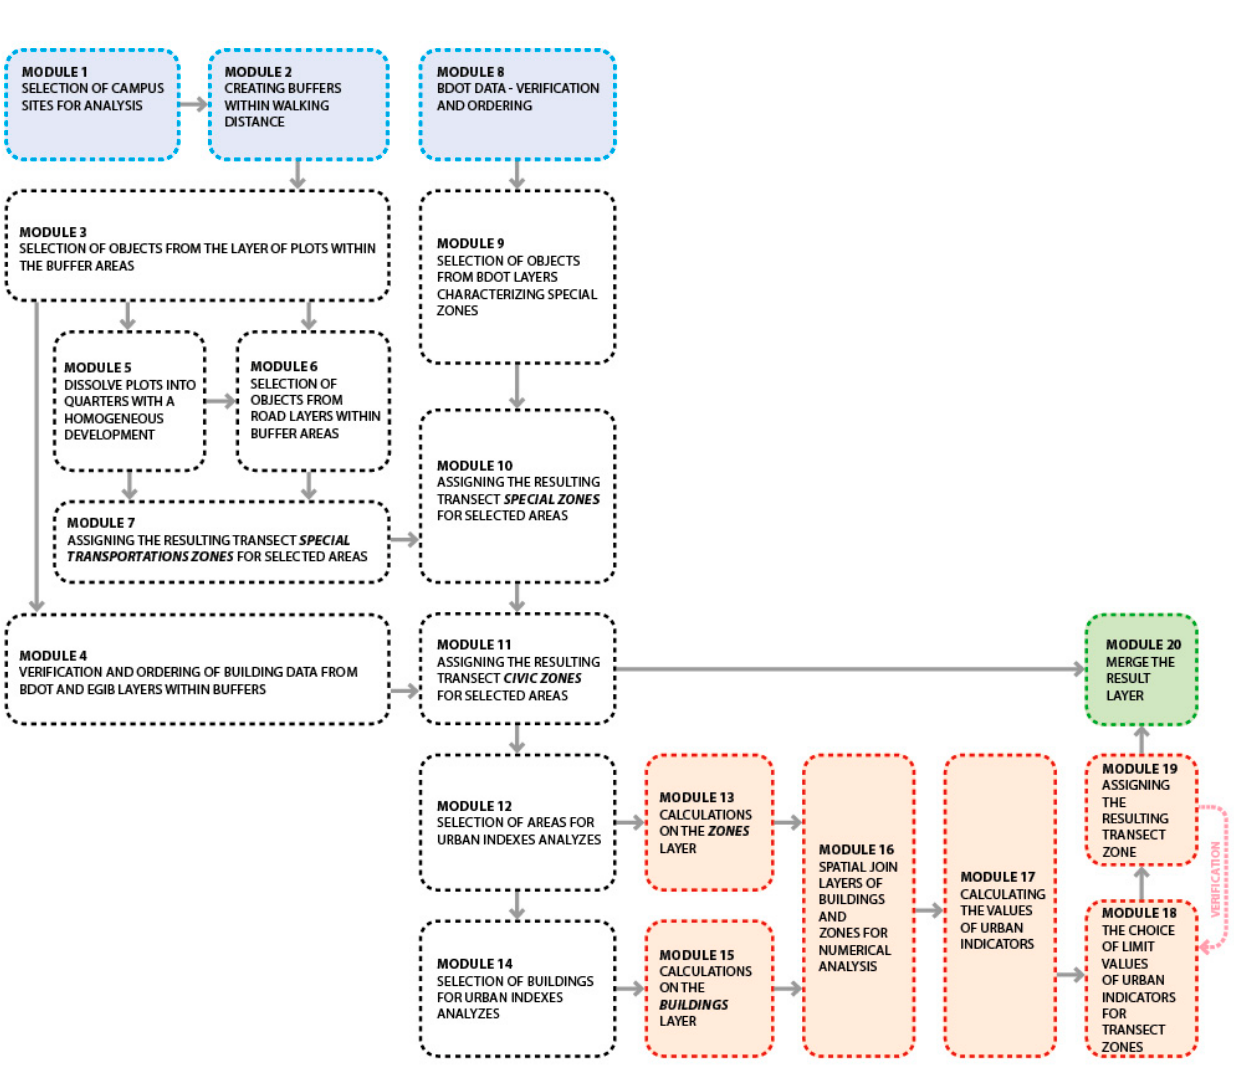
Figure 5. A simplified diagram of developing the tool to describe the spatial structure of the city. Source: own study.